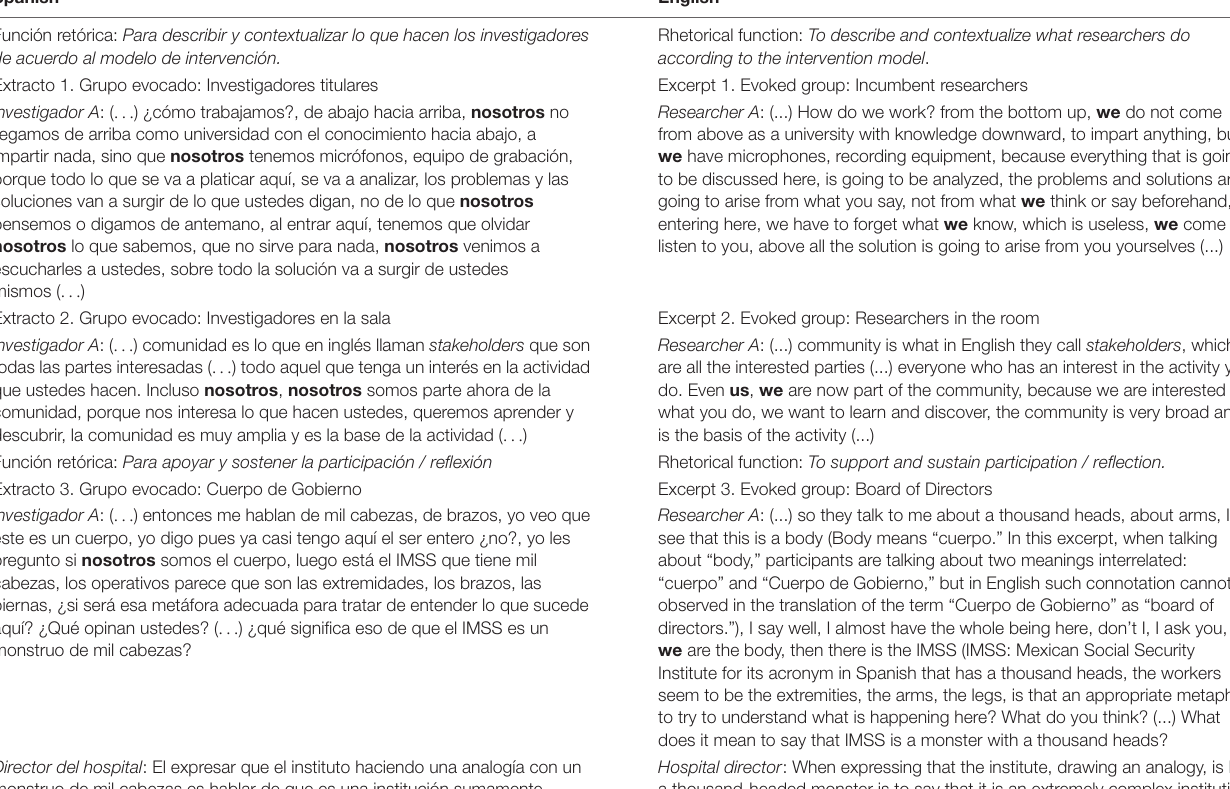
TABLE 2 | Exemplary excerpts of identity categories used by researchers in the first session. Spanish